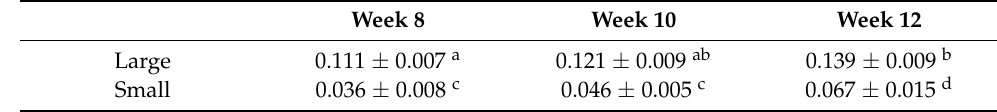
Table 4. Average weight by size and age (g) of the yellow